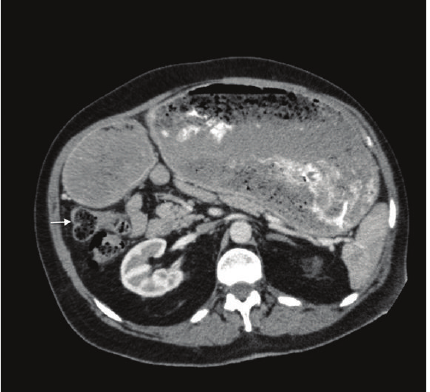
Figure 3: Coronal CT showing marked gastric distension with large amount of intraluminal gastric contents. A small bowel feces sign (arrow) is also appreciable in the region of the pylorus and the first portion of the proximal duodenum with surrounding adjacent inflammatory changes and mucosal wall thickening.